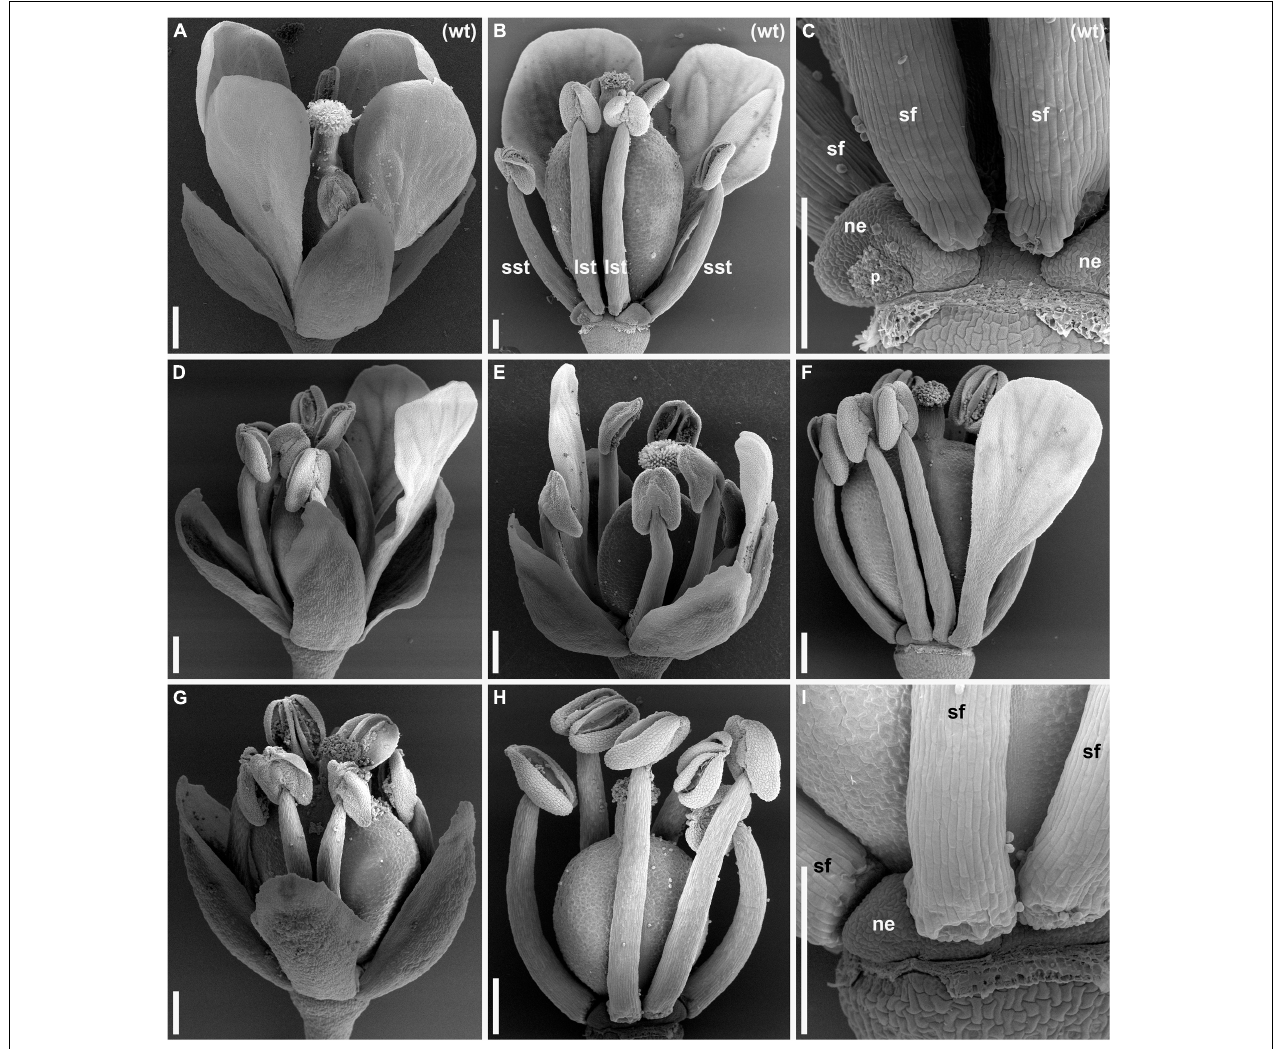
FIGURE 1 | Anthetic flowers of wild type (A–C) and lepidium-like ( lel ) (D–I) plants of Capsella bursa-pastoris [scanning electron microscopy (SEM)]. (A) Side view of wild-type flower with four conspicuous petals. (B) Wild-type flower with all sepals and two of four petals removed. (C) Detail of (B) showing a nectary that is closely associated with a petal. (D,E) Flowers with two petals. (D) The two petals are in adjacent positions. (E) The two petals are in diagonal positions. (F) Flower with one petal; sepals are removed. (G–I) Flowers having no petals. (G) General view. (H) Flower with sepals removed. (I) Detail of (H) showing a nectary. lst, long stamen; ne, nectary; p, scar of removed petal; sf, stamen filament; sst, short stamen; wt, wild type. Scale bars: 300 µ